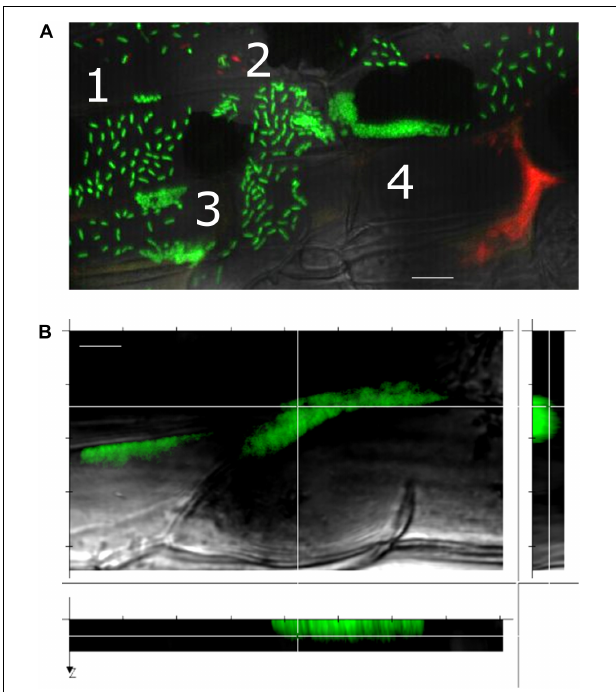
FIGURE 4 | A gallery of bacterial assemblies on the root surface. (A) Image showing diverse assemblies of green SBW25 cells on the root surface: 1, individual cells; 2, cell doublets; 3, microcolonies; and 4, biofilms. (B) Projection of a reconstructed 3D volume with side views reveals a vertical alignment of cells within the biofilm. Scale bar indicates 10 µ m length. Observations were performed in a root zone similar as that shown in Figure 3